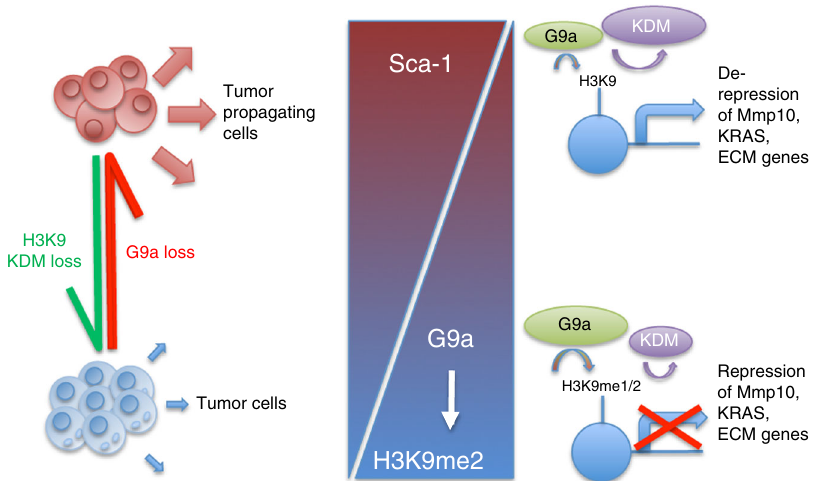
Fig. 5 H3K9 methyltransferases and demethylases control lung tumor-propagating cells through transcriptional regulation of Mmp10, KRAS and ECM genes. In lung adenocarcinoma non-stem tumor cells, G9a is relatively highly expressed and H3K9me2 KDMs are relatively under-expressed. Chromatin is relatively enriched in H3K9me2, which represses the transcription of Sca-1, Mmp10, and other genes associated with mutant KRAS and ECM regulation. Loss of G9a or gain of H3K9me2 KDMs reduces H3K9me2 and allows for the expression of previously repressed genes. This enables tumor cells to acquire the tumor-propagating cell phenotype, and the expansion of the tumor-propagating cell population drives lung adenocarcinoma progression and metastasis. Re-expression of G9a or antagonism of H3K9me2 KDMs can reverse the TPC phenotypes, mitigating lung adenocarcinoma